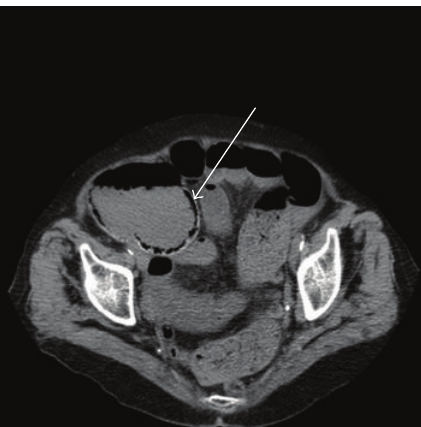
Figure 1: Abdominal CT scan showing air entrapment in the right colonic wall (marked by arrow), colonic liquid levels resembling co- lonic obstruction, and suspicion of sigmoidal volvulus.